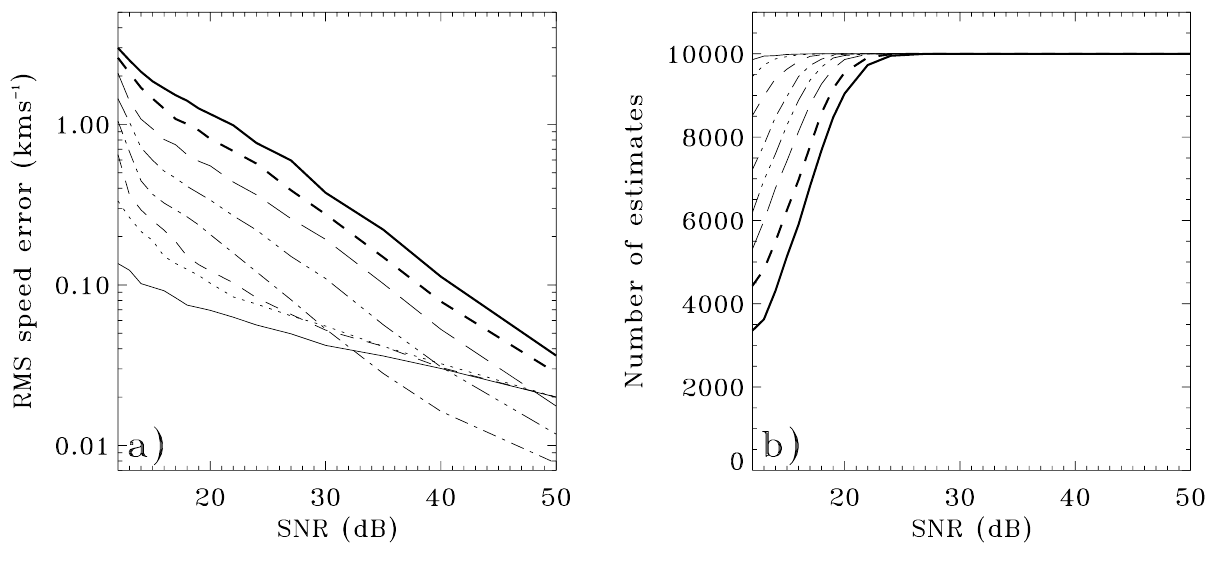
Fig. 5. (a) RMS error in speeds and (b) number of speed estimates made using the Fresnel Transform for a PRF of 440Hz with 4 coherent integrations for a 31MHz radar sampling an echo with range 150 km and decay time of 0.26s for various different meteoroid speeds: 10kms − 1 (fine solid line), 20kms − 1 (dotted line), 30kms − 1 (dashed line), 40kms − 1 (dot-dashed line), 50kms − 1 (triple dot-dashed line), and 60kms − 1 (long dashed line), 70kms − 1 (thick dashed line) and 80kms − 1 (thick solid line).